Question: What visual encoding does this figure use to show its data?
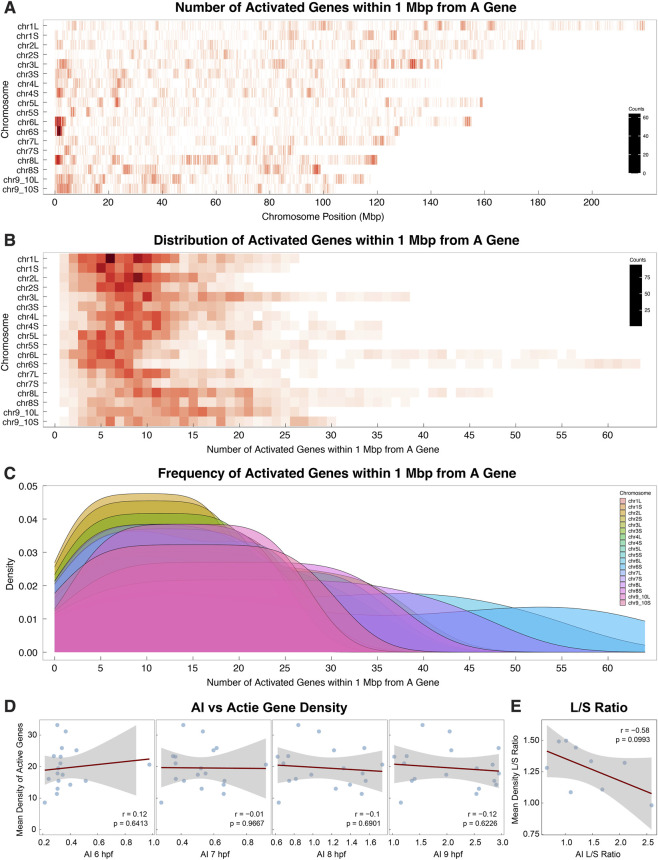
Answer: heatmap